Question: Sum up the contents of this chart in one sentence.
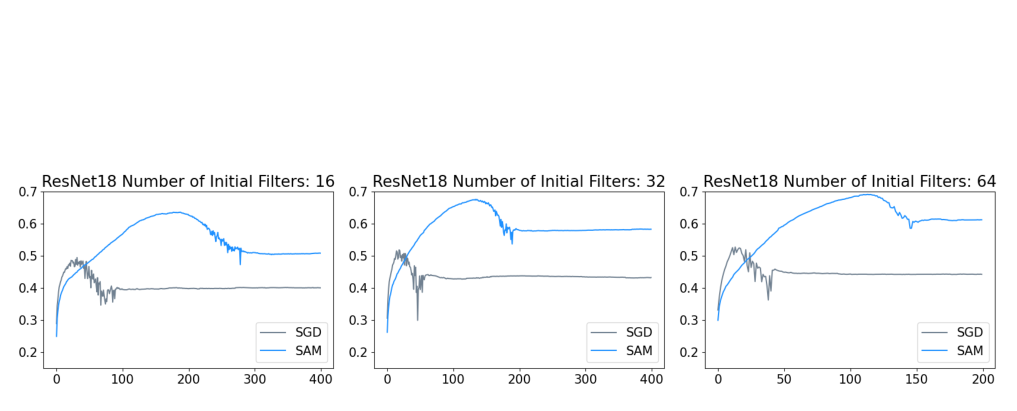
Answer: Behavior with model width for ResNet18/CIFAR10 with 30% label noise ResNet18 starts with 64 convolutional filters, and the filters double every two convolutional layers. We reduce the width of ResNet18 by 1/2 and 1/4 by starting with 32 and 16 initial number of filters, respectively. We see that SAM (ρ = 0.01) and SGD both improve in terms of performance as model width increases.